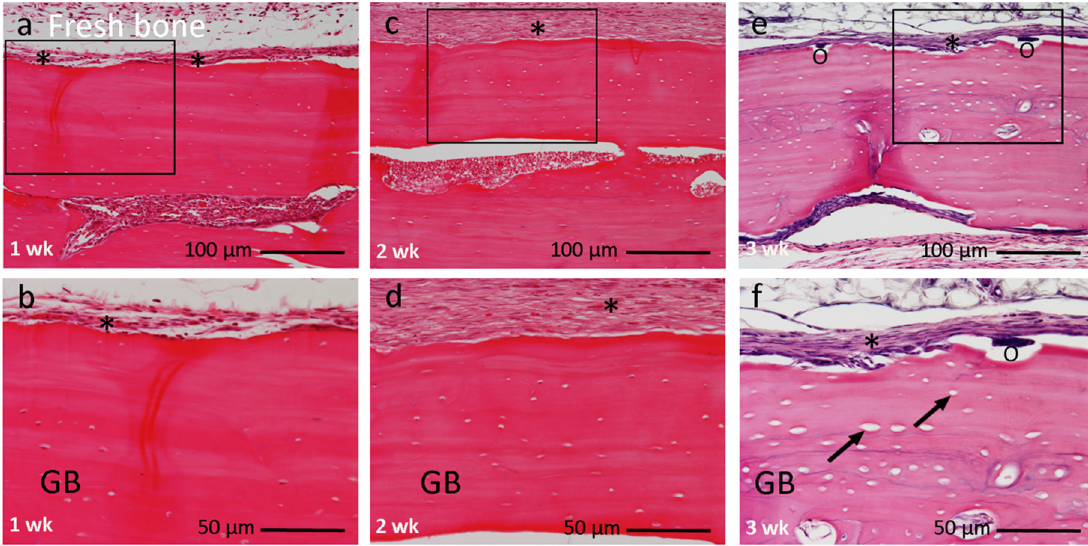
Figure 4. Histological image of the fresh bone group at 1, 2, and 3 weeks after implantation with higher magnification. ( a , b ) At 1 week graft bone encapsulated by few layers of connective tissue (*). ( c , d ) At 2 weeks, graft bone encapsulated by a thick layer of fibrous connective tissue (*). ( e , f ) At 3 weeks, shallow excavation pit with multinucleated giant cells (O). No new bone formation. Boxes within a, c, e indicate focused area in ( b , d , f ), respectively. ( a , b ) 1 week, ( c , d ) 2 weeks, ( e , f ) 3 weeks. Magnification: ( a , c , e ) 10×, ( b , d , f ) 20×. ( ) = empty lacunae. Bar: ( a , c , e ) 100 μ m; ( b , d , f ) 50 μ m.